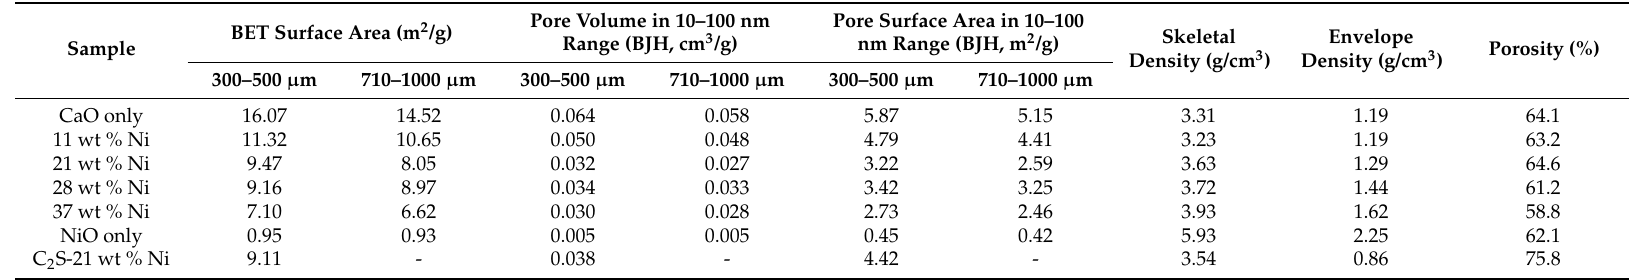
Table 5. Combined, catalytic and sorbent containing particles (300–500 and 710–1000 µ m) characteristics from Brunauer-Emmett-Teller (BET), Barrett-Joyner-Halenda (BJH) and mercury intrusion porosimetry (MIP) analysis, density and porosity calculated for 300-500 µ m combined particles